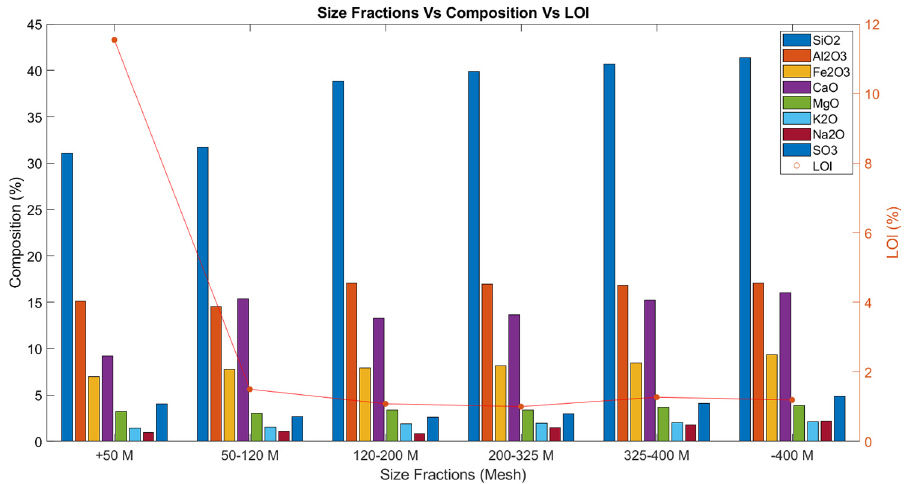
Figure 3. Major Elements Composition and Loss on Ignition of the different size fractions.